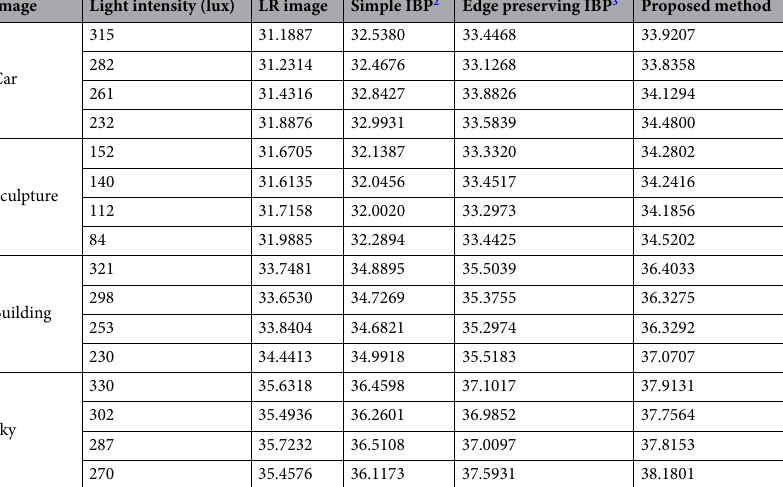
Table 1. Peak Signal to Noise Ratio(PSNR) in dB.